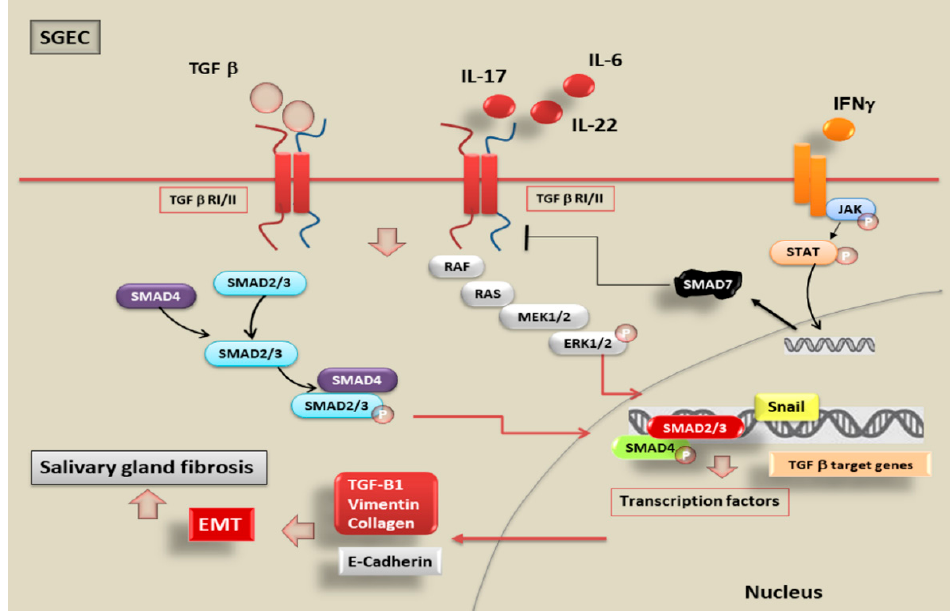
Figure 3. Hypothetical scheme illustrating TGF- β /EMT signalling in SS. TGF- β activates both the canonical SMAD2/3 pathway and the non-canonical MAPK pathway, triggering the EMT process. An inflammatory microenvironment including proinflammatory cytokines such as IL-17, IL-22, and IL-6 may induce EMT through the TGF- β /SMAD and non-SMAD signalling pathways. The activation of transcription factors such as Snail, promotes the prolonged activation of EMT, repressing epithelial marker genes, as E-Cadherin, and activating genes regulating the mesenchymal phenotype, as Vimentin and Collagen Type 1. The epithelial cells trans-differentiated in myofibroblasts are responsible for progressive SG fibrosis. Alternatively, TGF- β can trigger the signals via non-SMAD pathways, such as the MAPK signalling cascade including phosphorylated ERK1/2, that ultimately lead to the activation of the EMT-dependent fibrosis program. An alternative hypothetical mechanism was also showed mediated by IFN- γ that, through the Jak1/Stat1 activation, causes the SMAD7-mediated inhibition of TGF- β signalling.